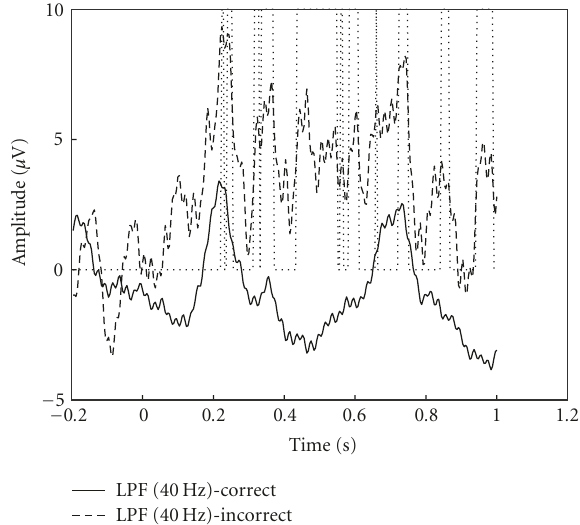
Figure 14: Comparison between averages of correct and incorrect trials lowpass filtered at 40Hz, from condition B. Dotted vertical line indicates time points at which di ff erence between two condi- tions was significant ( P < .